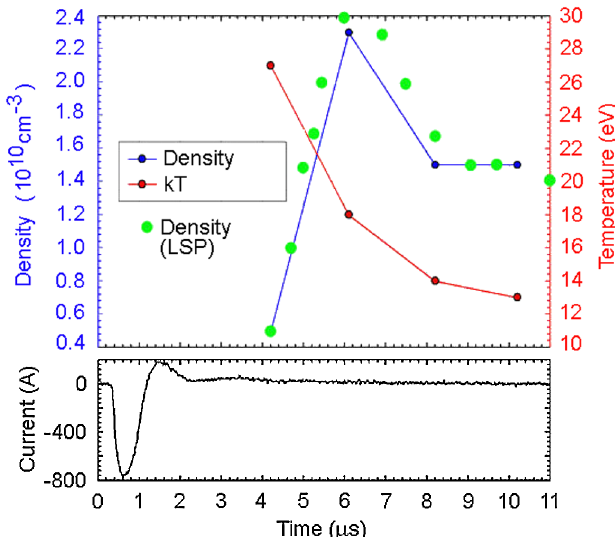
(cid:9) t (cid:10) (top, blue) and T FIG. 13. (Color) On-axis n p measurements at the midplane of a ferroelectric ceramic seg- ment, with discharge current shown (bottom). Comparison to (cid:9) t (cid:10) from simulation (top, green) is provided for the initial n p (cid:6) T (cid:6) 20 eV conditions T i e